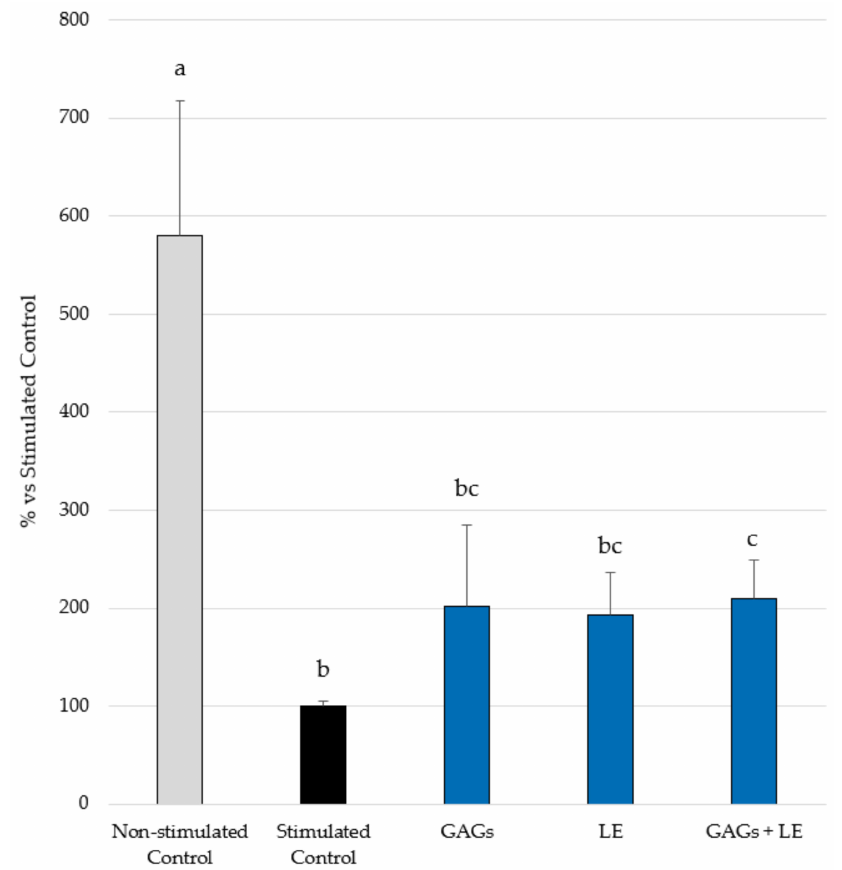
Figure 2. Filaggrin expression in reconstructed human epidermis (RHE) under cytokine mix (IL-4 + IL-13 + IL-22 + TNF- α at 3 ng/mL each)-stimulated conditions and treated or not (Stimulated Control) with the test compounds (LE and GAGs), alone or in combination, at 0.02 mg/mL each. Mean ± SEM values of % of stimulated control are shown. Different letters indicate statistically significant